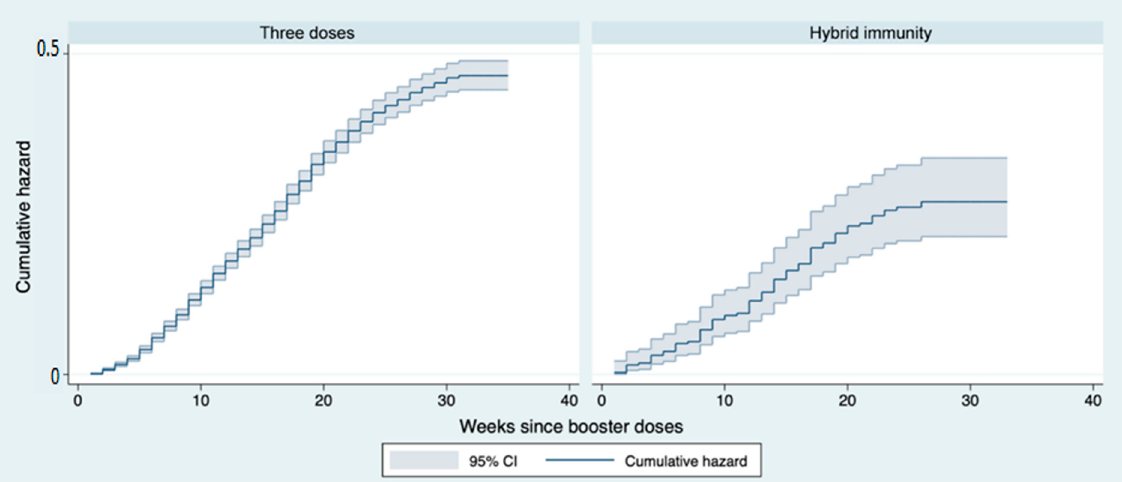
Figure 7. Nelson–Aalen cumulative hazard estimates: curves representing the cumulative risk of infection after booster dose stratified by type of immunity in the follow-up period.